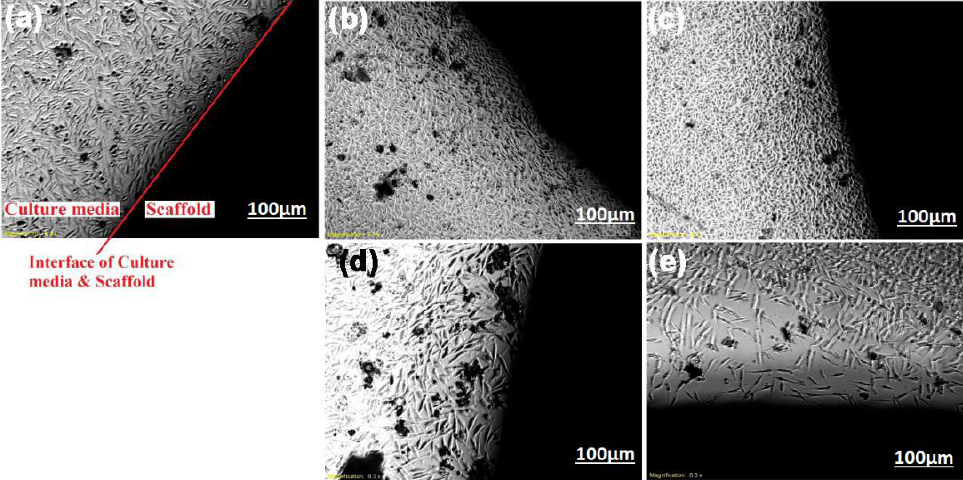
Figure 6. Density of proliferated cells in the interface of: ( a ) HA. ( b ) HA-0.5Li. ( c ) HA-1Li. ( d ) HA-2Li. ( e ) HA-4Li showed by optical microscopy.